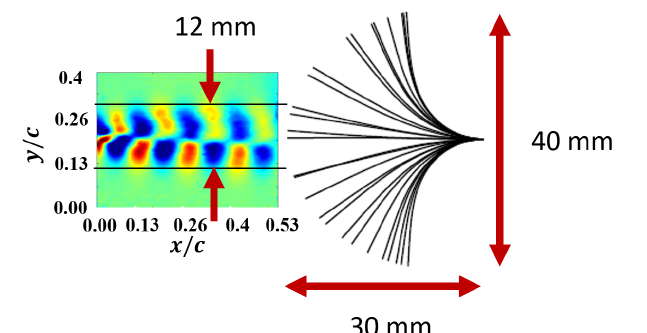
Figure 18. Momentum deficit contours in the wake of NACA 0012 airfoil with and without the inverted